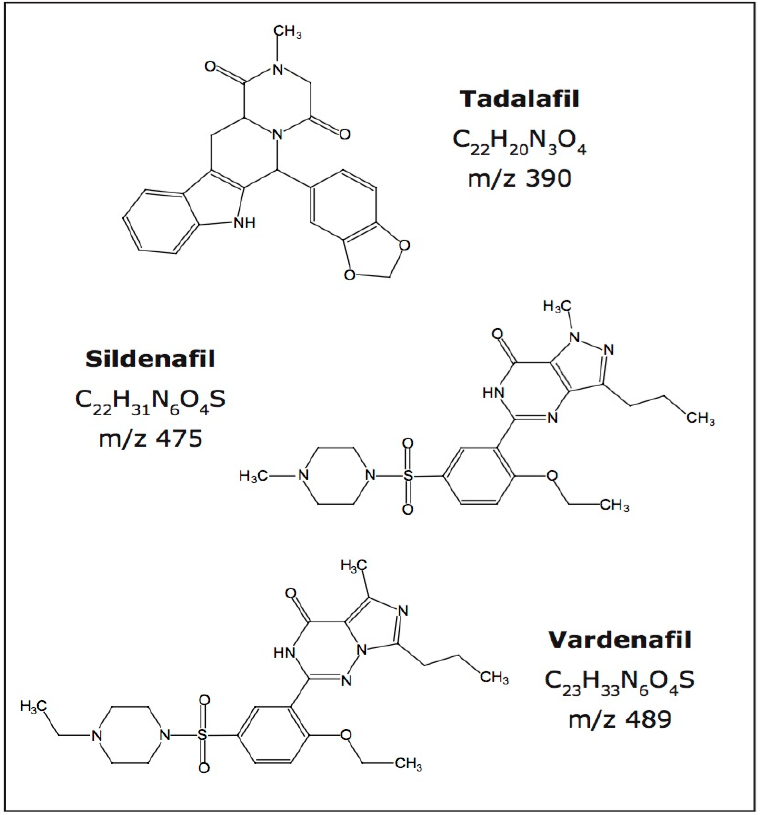
Figure 1. Chemical structure of sildenafil, tadalafil and vardenafil.